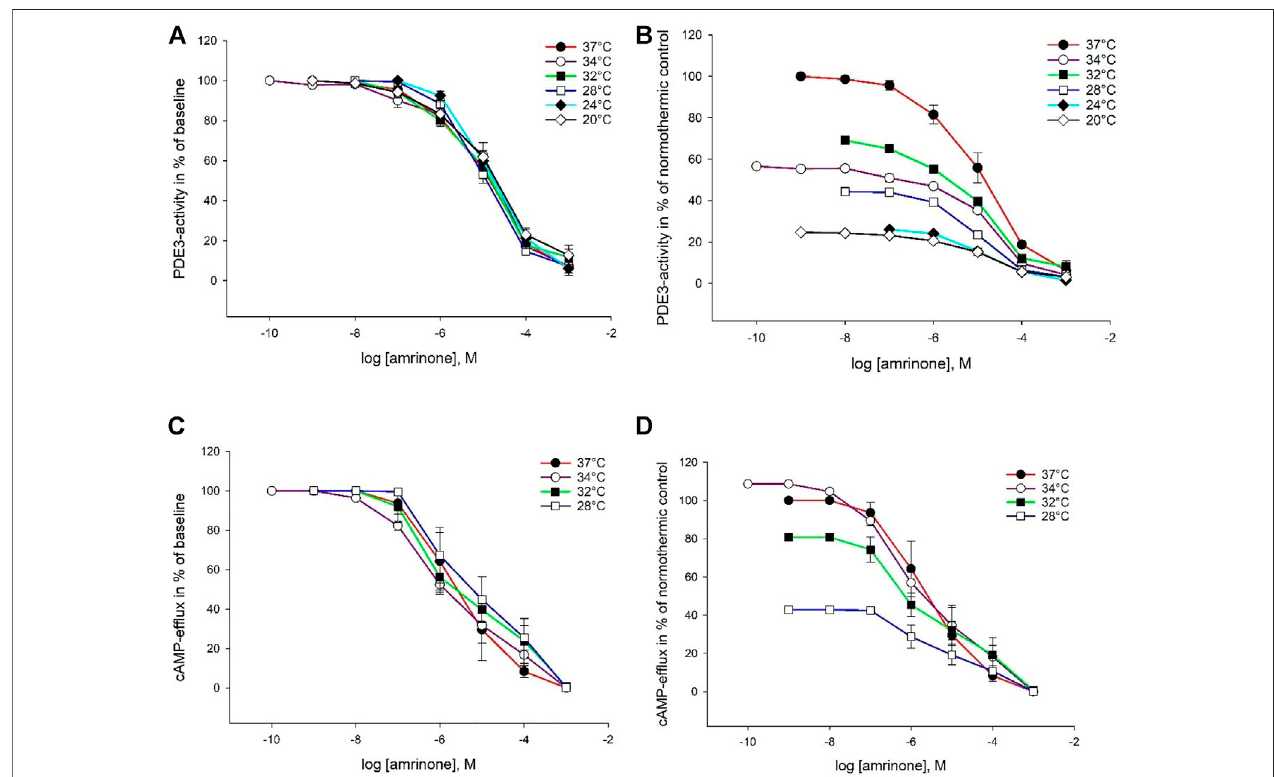
FIGURE 3 | Temperature-dependent inhibition of PDE3 and cAMP-ef fl ux by amrinone. The doses are in logarithm of the concentration in mol/L, presented as means ± SEM. (A) Inhibition curves for PDE3-activity at temperatures ranging from 37 ° C to 20 ° C. (B) Inhibition curves for PDE3-activity in % of normothermic inhibition curve at temperatures ranging from 37 ° C to 20 ° C. (C) Inhibition curves for ABCC4-activity at temperatures ranging from 37 ° C to 20 ° C. (D) Inhibition curves for ABCC4- activity in % of normothermic inhibition curve at temperatures ranging from 37 ° C to 20 ° C.